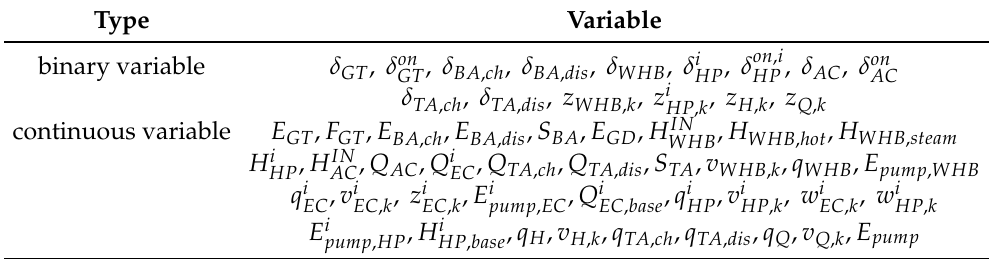
Table 2. Decision variables in the optimization for IES.